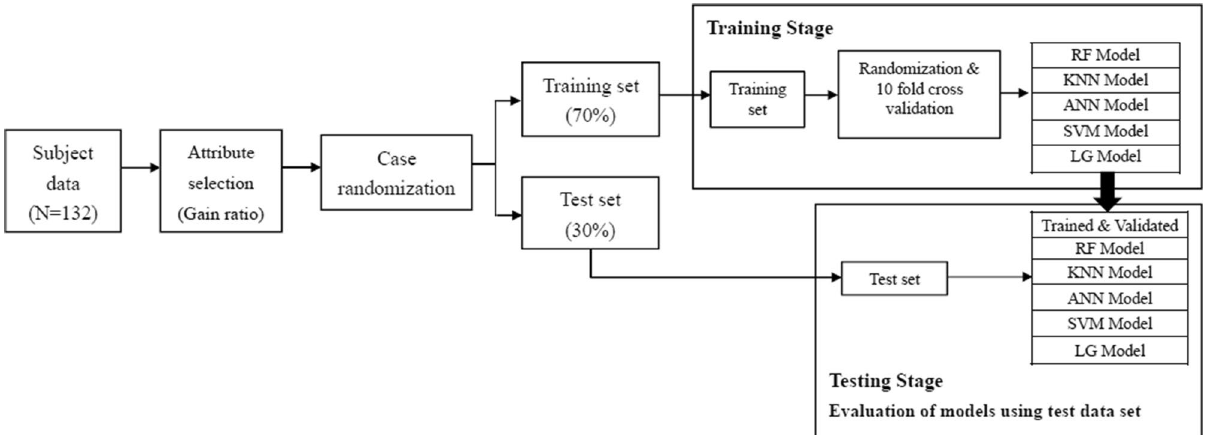
Figure 1. The flow chart of model development and validation process. Subject data were randomized into a training set and a test set. The training set was 70% of the data and the test set was 30% of the data. For the training data set, the tenfold cross validation procedure was used to train and build 5 machine learning models (i.e., the RF, KNN, ANN, SVM and LG) in which the data was randomly split into 10 groups (9 groups for training and 1 group for validation). The tenfold cross validation process repeated until all 10 groups of data were trained and validated. The tenfold cross validation process was performed for all 5 machine learning models. After the 5 models were built, the test data set was entered into the 5 models to determine the model Model development and testing. Figure 1 shows the model development and testing process. Data were randomized and divided into a training data set (70%) and a test data set (30%) 64 . The training data set was used for training and developing the model. The test data set was used for final evaluation of model performance. The tenfold cross validation procedure was performed to train the models 65 . During the tenfold cross validation process, the training data set was split into 10 groups, where 9 of them were used for training the model while the remaining one was used for validating the model. This process was repeated until all groups of data had been trained and validated. After the model was built, the testing data set was entered into the model to assess the model performance. The hyper-parameters of the prediction models were determined according to the procedures used in the ML literatures. For the RF model, the numbers of trees to build were 100 and the numbers of features to consider at a node were the first integer less than log2M + 1 (M is the number of inputs) 66 . For the KNN and ANN models, the tenfold cross validation was employed to tune the value of hyper-parameters (i.e., the k value of the KNN; the numbers of hidden neurons in the hidden layer of the ANN) 10 . We found that k = 5 and the numbers of hidden neurons = 3 in one hidden layer (the main SIS scale) and k = 9 and the numbers of hidden neurons = 2 in one hidden layer (the SIS global rating scale) had the best prediction accuracy. As a result, these hyper-parameters were used in the KNN and ANN models. For the SVM model, the polynomial kernel function was employed because it provided the best prediction accuracy 58,59 . Model performance metrics. The performance of ML models was evaluated using the standard ML per- formance metrics including (1) accuracy, (2) recall, (3) precision, (4) F1 scores, and (5) area under the receiver operating characteristic curve (AUC-ROC) 15 . Accuracy is an overall index of prediction performance. Accuracy was computed as the sum of true positive (TP) and true negative (TN) divided by the sum of TP, TN, false posi- tive (FP) and false negative (FN). Recall is the ratio of participants that were correctly identified as positive by the model to those whom were actually positive. Recall was computed as the TP divided by the sum of TP and FN. Precision is the ratio of participants that were correctly identified as positive by the model to those were labelled as positive by the model. Precision was calculated as TP divided by the sum of TP and FP. F1 scores is a combined index of precision and recall. It was calculated as the harmonic mean of precision and recall. The AUC-ROC is the ratio of area under the ROC curve to the total area. It represents the ability of the model to distinguish between classes. Statistical analysis. The continuous variables were standardized and the categorical variables were coded before developing the ML models. The Waikato Environment for Knowledge Analysis (Weka) 3.8.3 developed by the University of Waikato, New Zeeland was employed for model development, training and testing 67 . The Weka has been extensively used for constructing ML prediction models in various fields and in different patient populations in the medical field 11,68,69 .